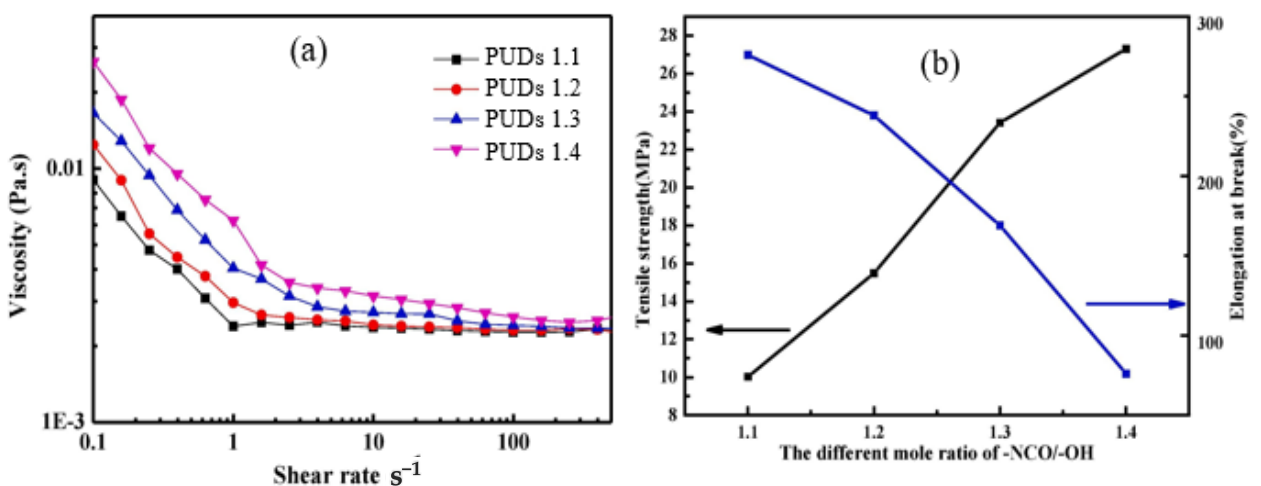
Figure 13. ( a ) shear rate dependence of PUDs viscosity at 25 °C for different R values. ( b ) Effect of R value on the tensile strength and elongation at break of different PU films (adapted with permission from [97]).